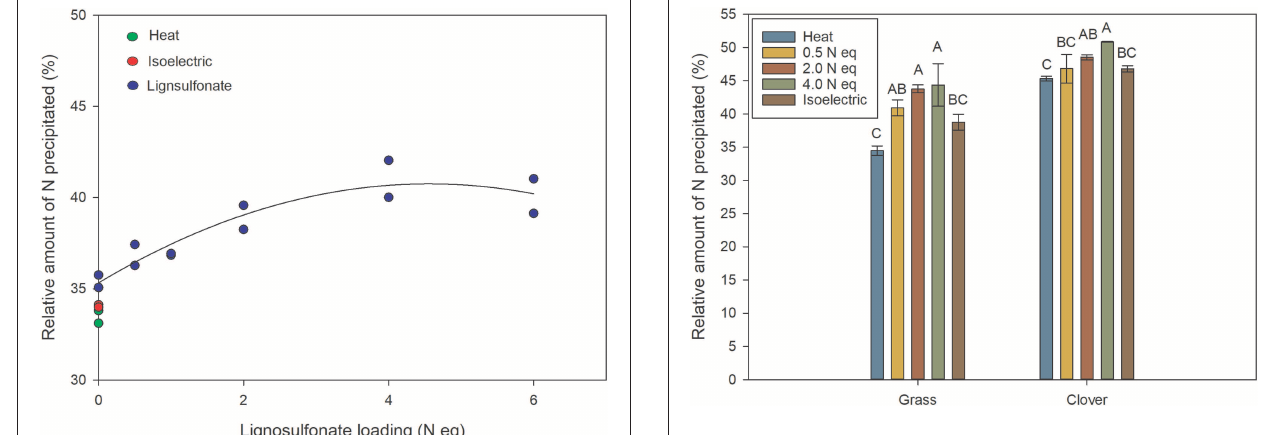
FIGURE 5 | Relative amount of N precipitated by heat, isoelectric precipitation, or lignosulfonate treatment of cleared juice from different biomasses. Values are means ± S.D. ( n = 3). Data were analyzed with ANOVA followed by a Tukey HSD test. Different letters denote significant difference at P =